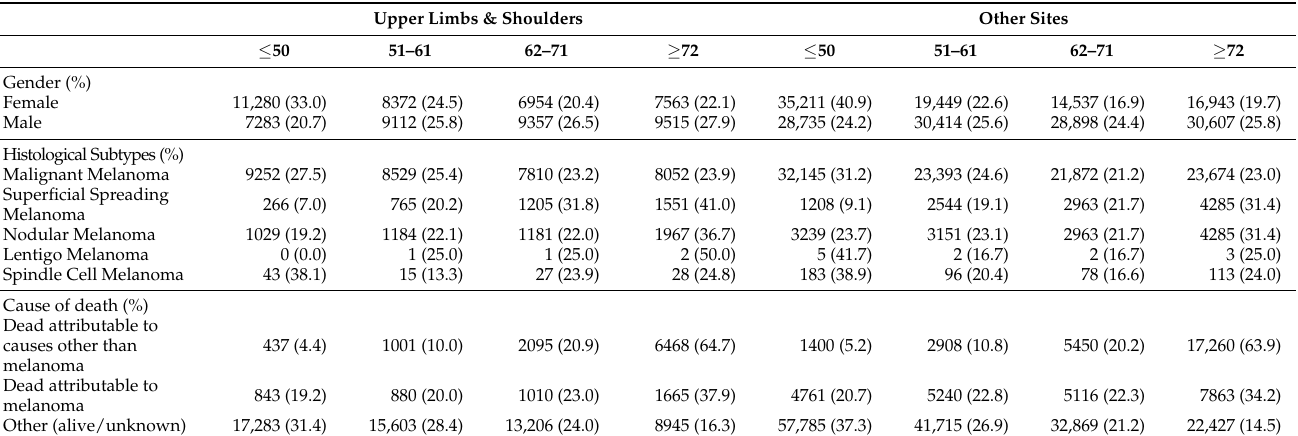
Table 2. Comparison between age